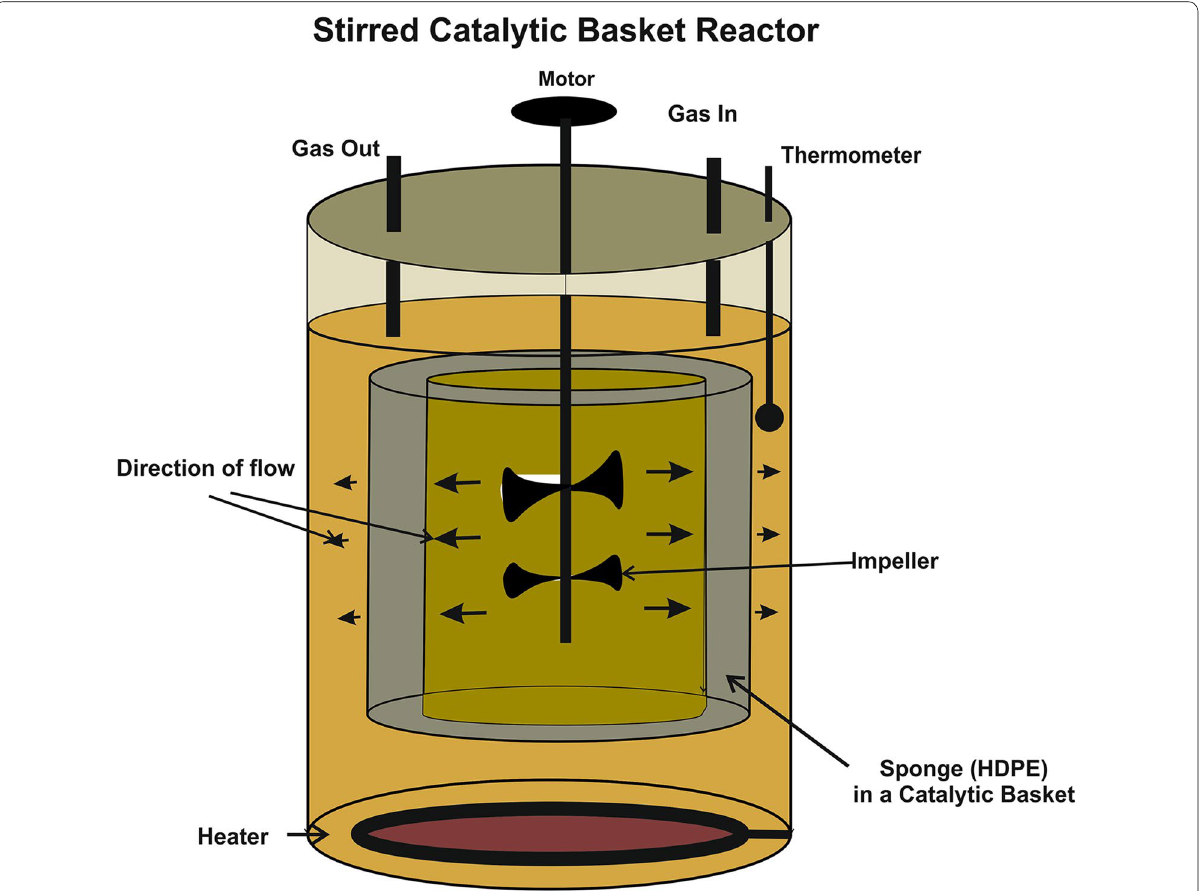
Fig. 1 Schematic representation of a Stirred Catalytic Basket